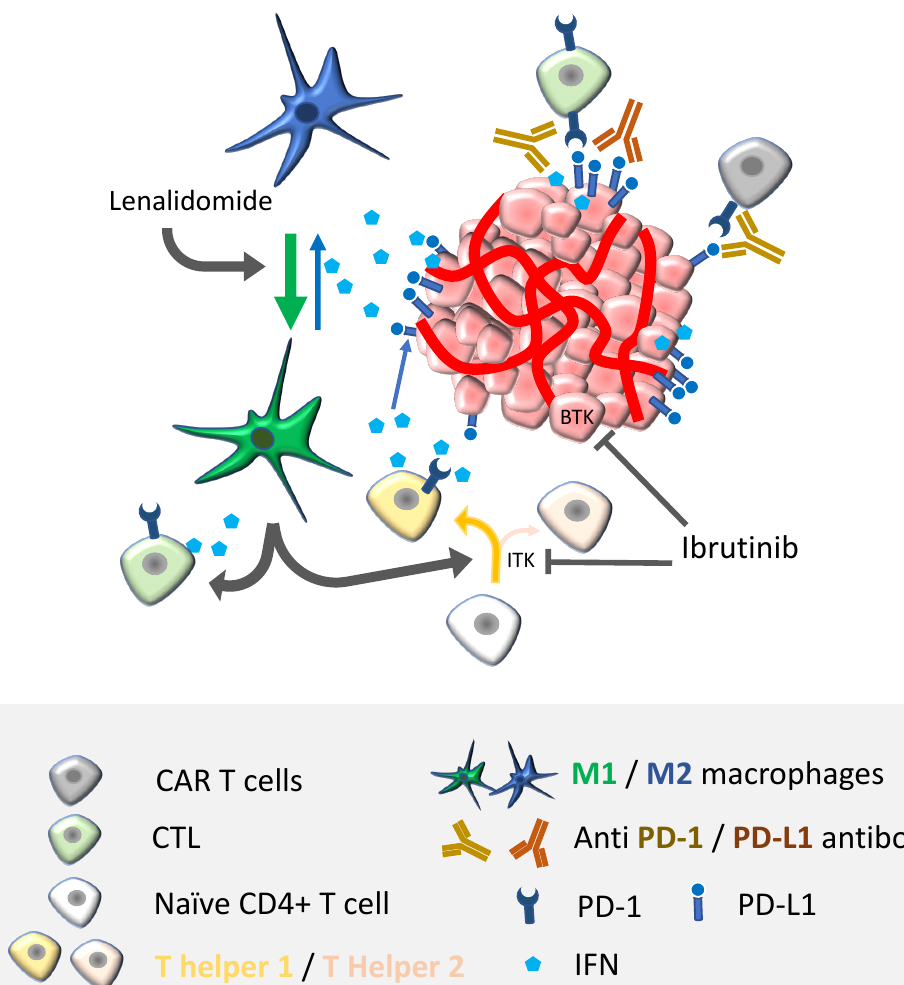
Figure 2. Perspectives for combination therapy in PCNSL. Besides just adding the effects from differ- ent treatments, one of the goals of combination immunotherapies is to find synergistic antitumor effects. Most of the direct antitumor activity is driven by antigen-specific or redirected T-cells (i.e., CAR-T cells). Therefore, unleashing antitumor response with immune checkpoint inhibitors should potentiate not only CAR-T cell responses, but also the effects of BTK/ITK inhibitors and immunomod- ulatory drugs, such as ibrutinib and lenalidomide/pomalidomide, respectively. Ibrutinib targets lymphoma cells by inhibiting BTK. Additionally, it regulates T-helper responses by limiting Th2 activation and inducing a shift in the Th2/Th1 ratio by targeting interleukin-2-inducible T-cell kinase (ITK). Lenalidomide/pomalidomide, by skewing M2-like macrophages towards M1 phenotypes, indirectly boosts cytotoxic T lymphocytes (CTL) activity and Th1 responses; therefore, enhancing IFN production, a cytokine that is well known for upregulating PD-L1 on tumor cells. Enhancing the adaptive antitumor immunity by using ibrutinib or lenalidomide/pomalidomide should, directly or indirectly, potentiate CAR-T cell